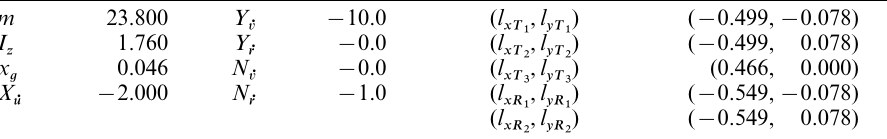
Table 1. Mass-related parameters with respect to CP for CyberShip